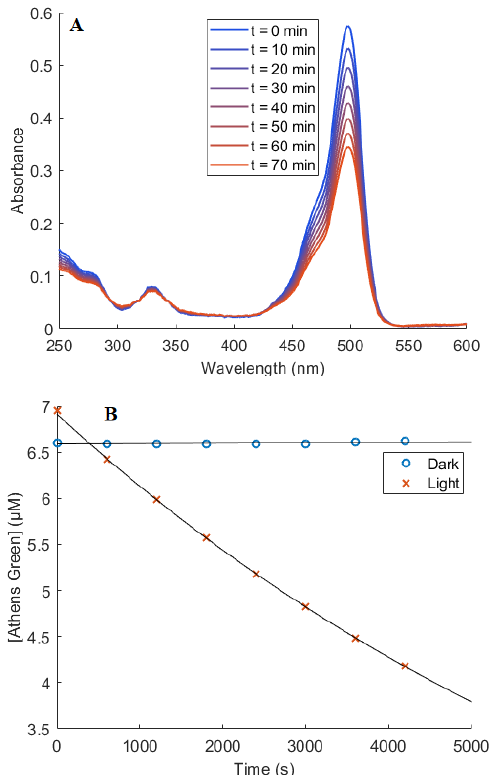
Figure 9. ( A ) Absorption spectra of Athens Green in D 2 O-PBS (pD 7.8) recorded as a function of the elapsed irradiation time of the O 2 (a 1 Δ g ) sensitizer AlPcS 4 at 670 nm. The absorption spectrum of AlPcS 4 does not change under these conditions and was subtracted to yield the data shown. ( B ) The concentration of Athens Green as a function of AlPcS 4 irradiation time (crosses). An independent sample, kept in the dark and monitored at identical intervals, did not show detectable absorption changes. The solid lines are fits to the pertinent kinetic rate equations for reactions with O 2 (a 1 ∆ g ) [45]. The size of the symbols in Figure 9B represent the errors on each data